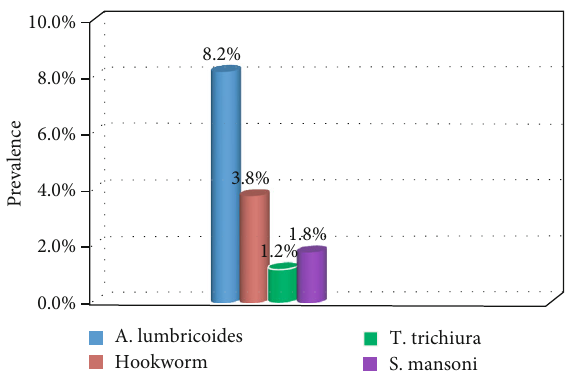
Figure 1: Distributions of STH and S. mansoni infections among Hiruy Abaregawi primary school children from March to April, 2019, Debre Tabor town, North West